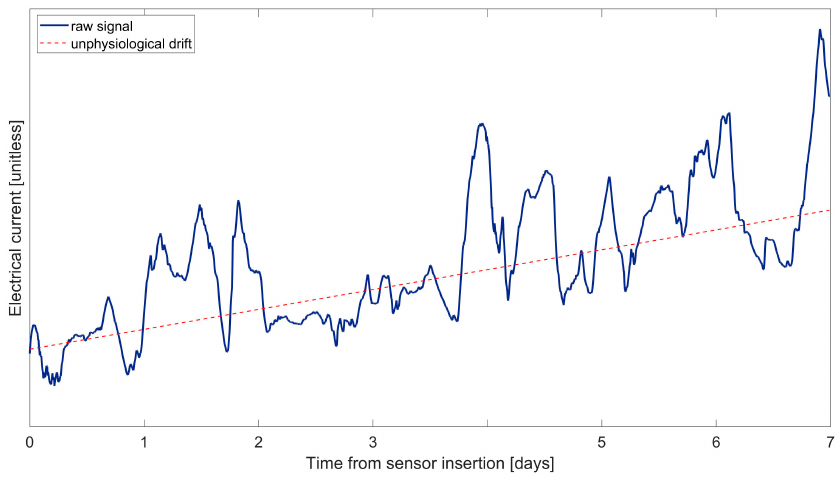
Figure 4. Representative raw CGM sensor signal (continuous line, units not specified by the manufacturer) that exhibits a nonphysiological drift (dashed line) due to the time-variability of sensor sensitivity. Data were previously published in [15].